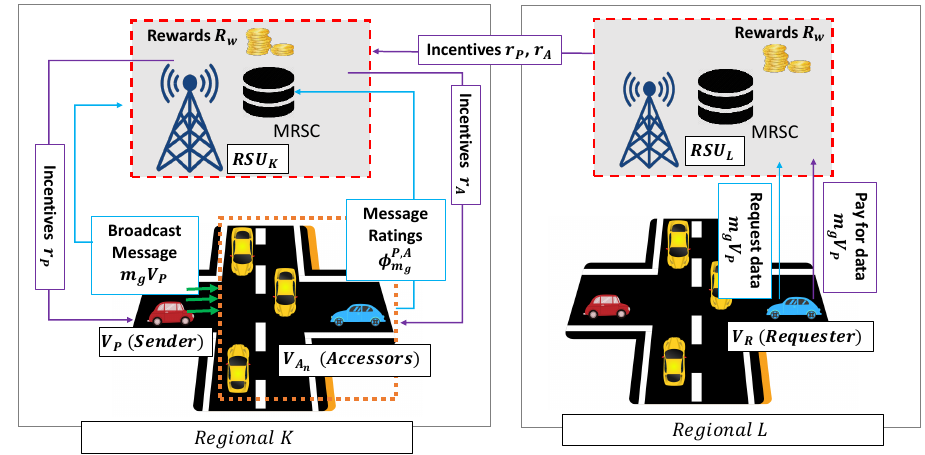
Figure 3. Block structure of transaction.